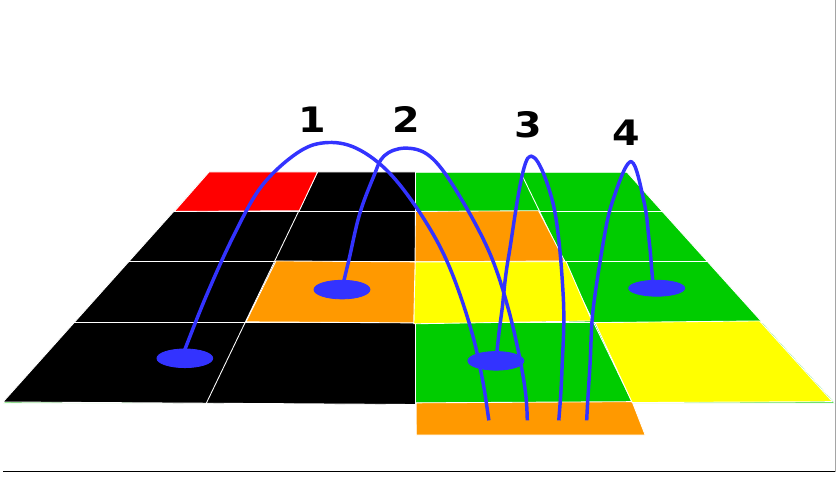
Figure 1. Hopping paths of four rabbits birthed at the lower extension (orange) of the cellular grid. Yellow cells are occupied by baby rabbits, orange cells are occupied by reproductive rabbits, and red cells are occupied by old/declining rabbits. Green cells represent uneaten food and black cells represent eaten